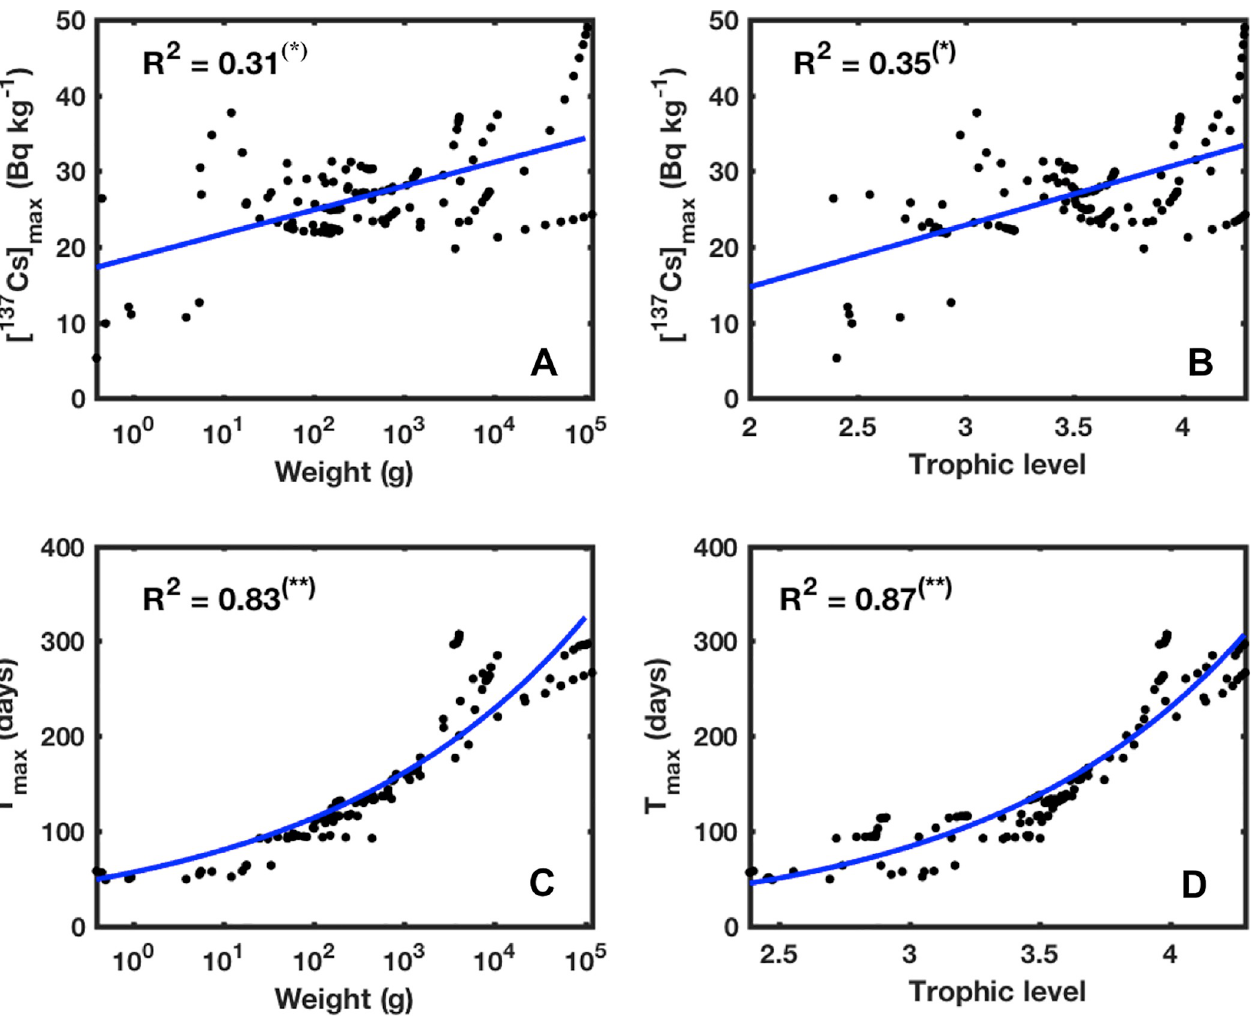
Fig 12. Predicted maximum activity concentrations (in Bq kg -1 ) and T max (in days) of the species-related cohorts, plotted as a function of the their weights and trophic levels. Significance level of the correlation: p > 0.05 (), p < 0.05 ( � ), p < 0.01 ( ��